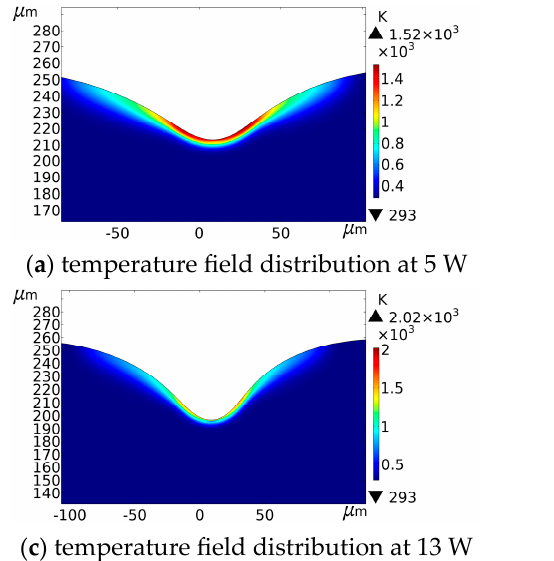
width = 40 ns, frequency = 150 kHz, scanning speed = 100 mm/s).